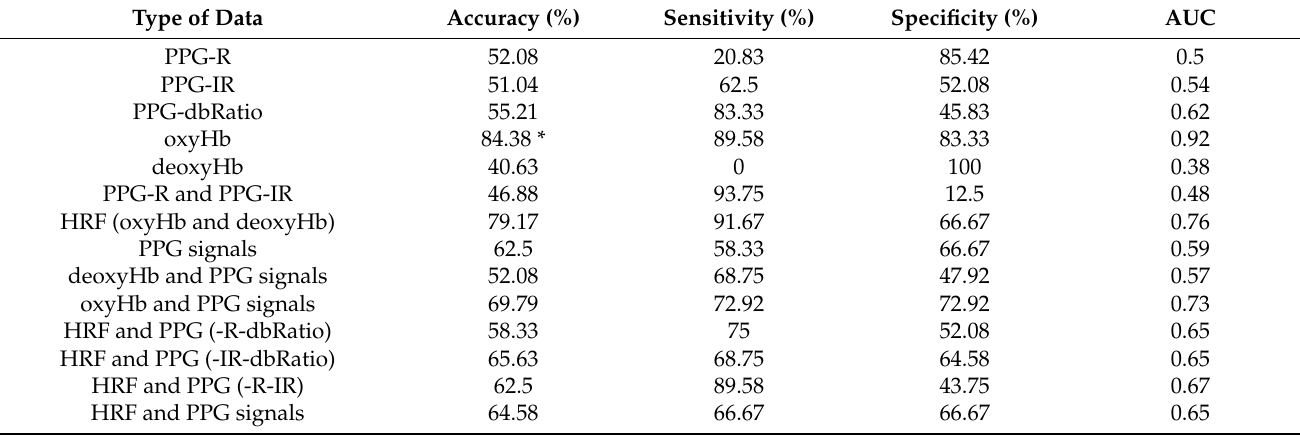
Table 3. Support vector machines with cubic kernel function; all signals were photoplethysmography signals (PPG-R, PPG-IR, and PPG-dbRatio) and hemodynamic response function signals (oxyHb and deoxyHb). The superscript asterisk is the best accuracy in